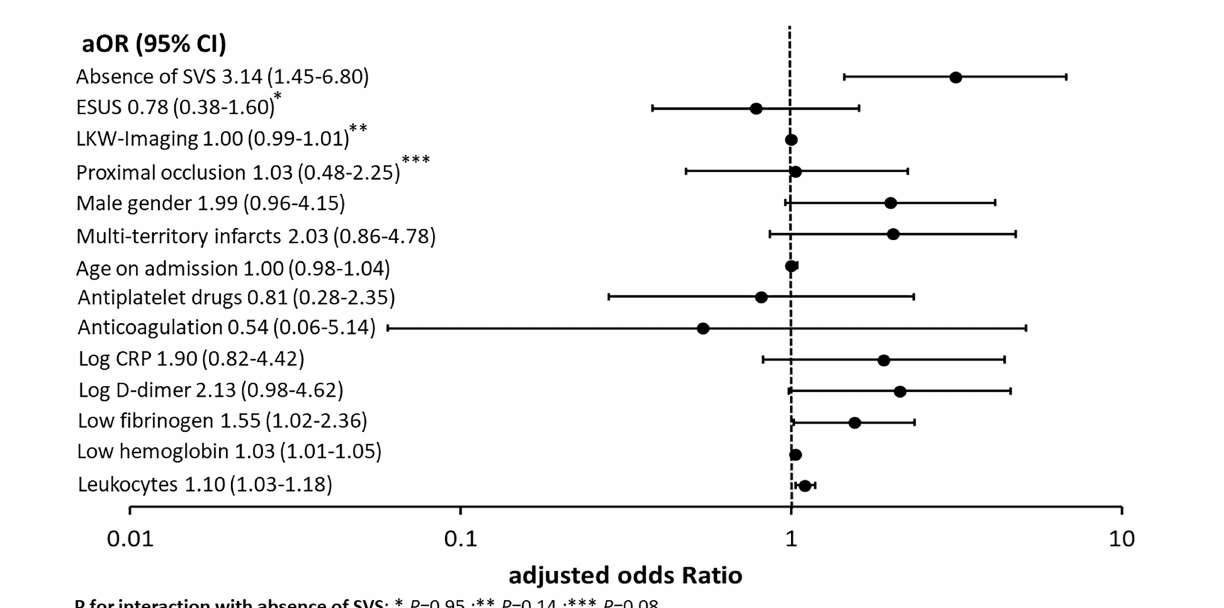
FIGURE 2 Association between active cancer, the absence of SVS, cancer-related imaging findings and blood biomarkers, and demographics in the multivariate logistic regression. This figure summarizes the association between active cancer, the absence of SVS and other preselected cancer-related biomarkers with corresponding adjusted odds ratios (aOR) and 95% confidence intervals (95% CI). The absence of SVS showed the strongest association with active cancer in this study cohort. CRP indicates C-reactive protein; ESUS, embolic stroke of undetermined source; LKW-imaging, time between last- known-well to imaging and SVS, susceptibility vessel